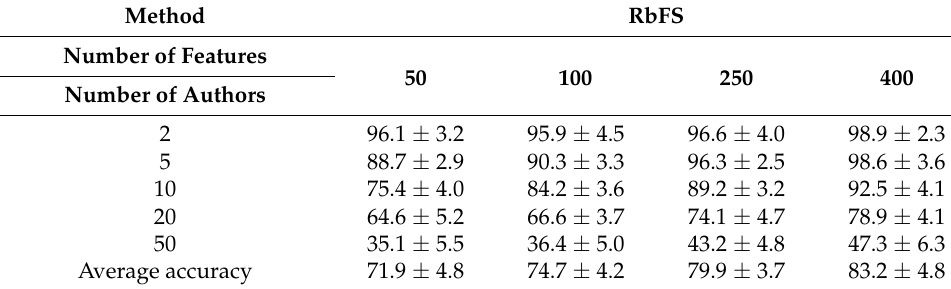
Table 4. Feature selection methods (RbFS).